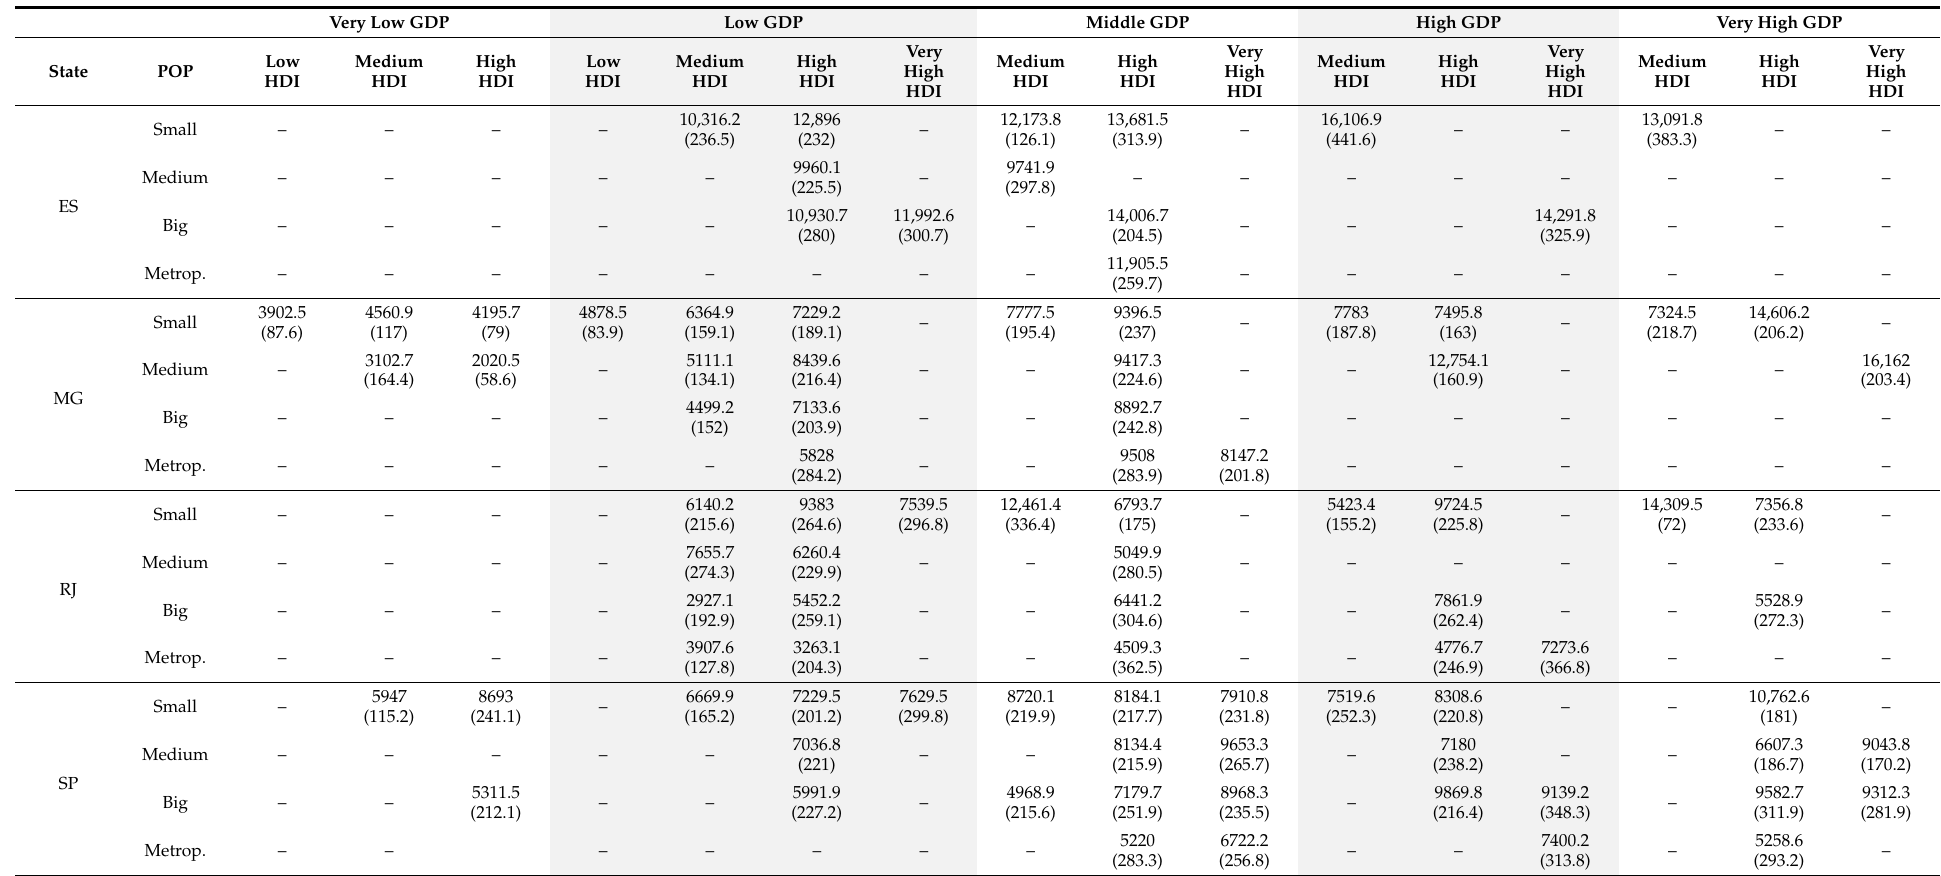
Table 1. Incidence coefficient per 100,000 inhabitants (mortality rate per 100,000 inhabitants), over the 62 weeks in the 4 states of the Southeast region, according to population size (POP); gross domestic product (GDP); and Municipal Human Development Index (HDI-M), also over the course of 62 weeks of the pandemic. Very Low